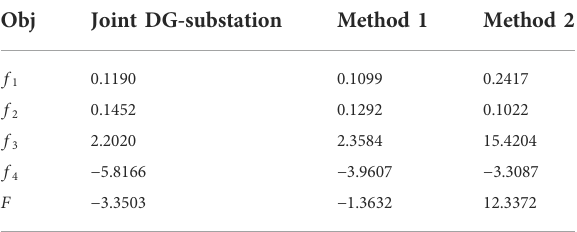
TABLE 3 Correlation analysis of the objective function in weight γ (cid:1) ( 0 . 25 , 0 . 25 , 0 . 4 , 0 . 1 ) . f 1 Pearson Correlation